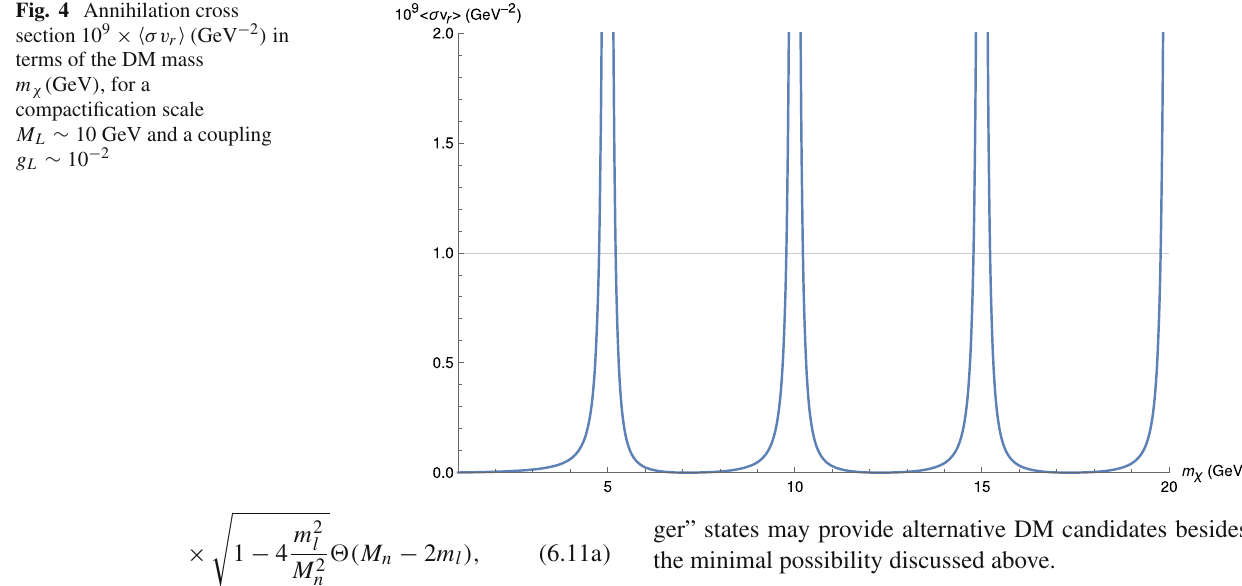
Fig. 4 Annihilation cross section 10 9 × (cid:18) σv r (cid:19) ( GeV − 2 ) in terms of the DM mass m χ ( GeV ) , for a compactification scale M L ∼ 10 GeV and a